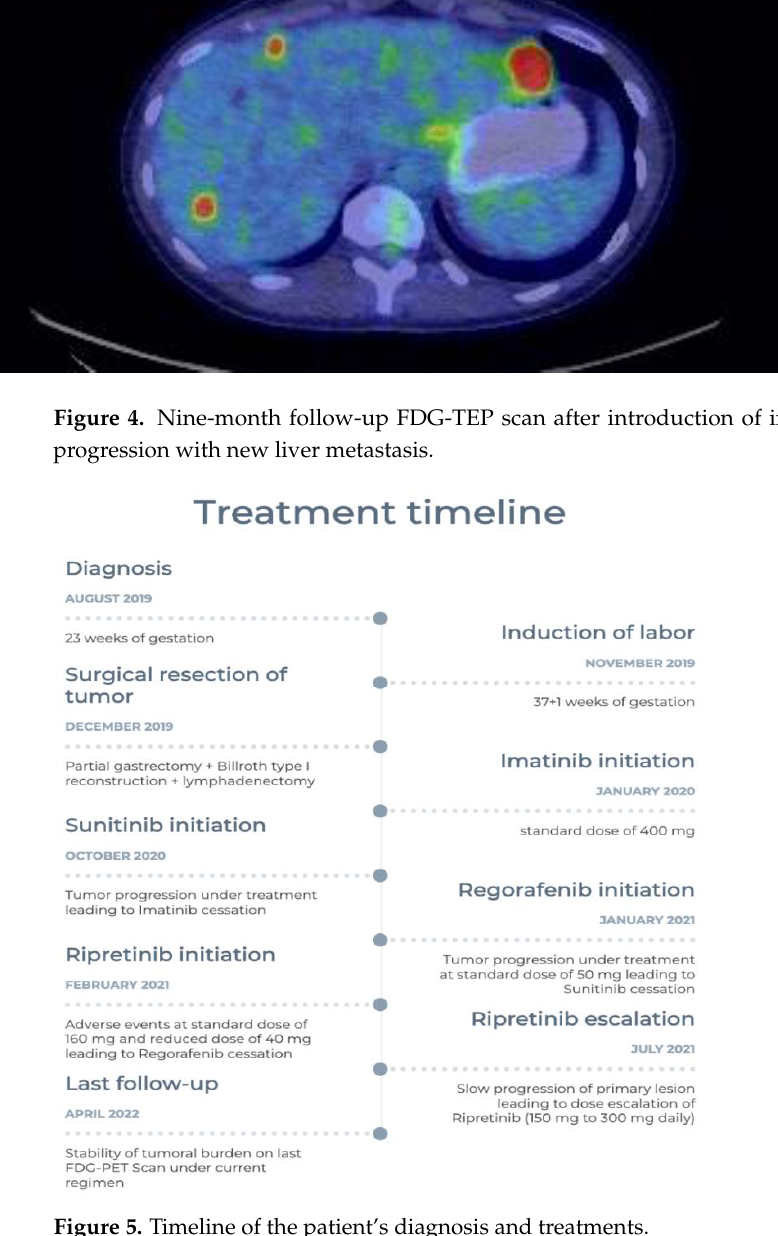
Figure 5. Timeline of the patient’s diagnosis and